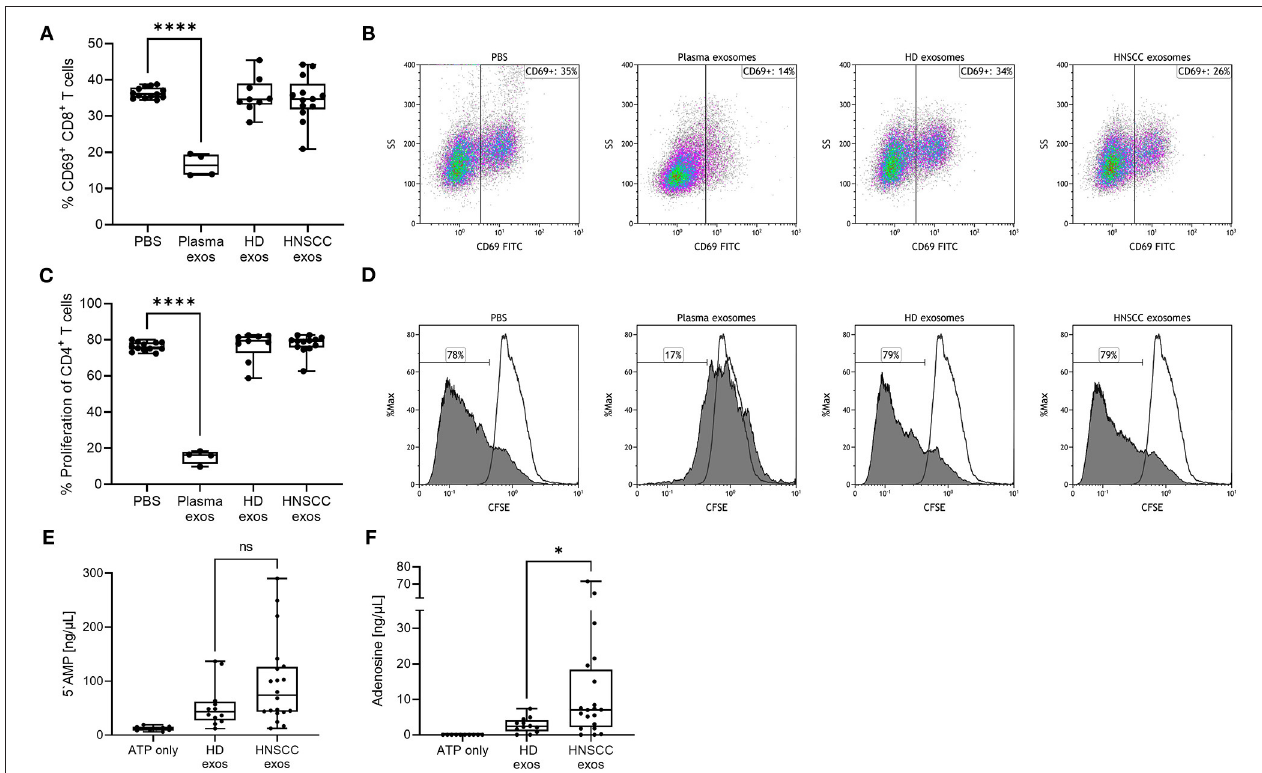
FIGURE 3 | Functional effects of saliva-derived exosomes on activated CD8 + T cells, proliferating CD4 + T cells and ATP metabolism. (A,B) Activated CD8 + T cells were co-incubated with saliva-derived exosomes from HD ( n = 9) and HNSCC patients ( n = 13) for 16h. CD69 expression of T cells was measured by flow cytometry. (B) shows representative plots for each condition. (C,D) CD4 + T cells were co-incubated with saliva-derived exosomes from the same HD (n = 9) and HNSCC patients ( n = 13) for 4 d. Proliferation was evaluated by CFSE assay and flow cytometry. (D) shows representative histograms for each condition. Filled histograms represent proliferated cells and framed histograms the unstimulated parental generation. For (A–D) , plasma-derived exosomes obtained from HNSCC patients ( n = 4) were included as positive controls. (E) 5’AMP and (F) adenosine levels were measured by mass spectrometry upon incubating saliva-derived exosomes of HD ( n = 12) and HNSCC patients ( n = 20) with exogenous ATP. Results in (A,C,E,F) are plotted as box-and-whisker blots representing the median value, the 25 th and 75 th quartiles and the range. P-values were determined by Mann–Whitney test, * p ≤ 0.05, **** p ≤ 0.0001, ns, not